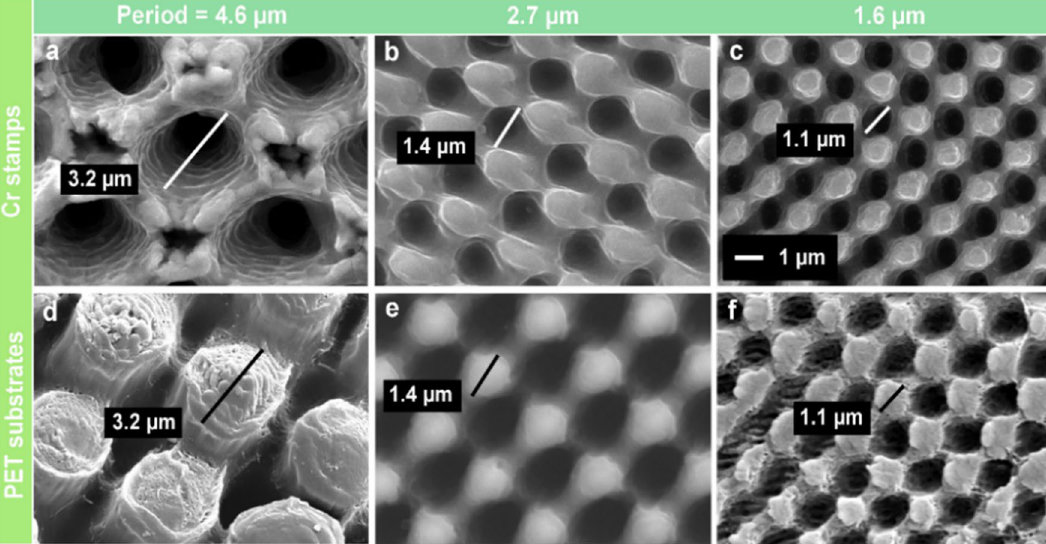
Figure 1. SEM micrographs of DLIP-produced hole-like periodic micropatterns on ( a – c ) chromium surfaces (stamp material) and pillar-like microarrays on ( d – f ) PET foils replicated from the stamps by hot-embossing. The spatial periods are: ( a , d ) Λ = 4.6 µm, ( b , e ) Λ = 2.7 µm and ( c , f ) Λ = 1.6